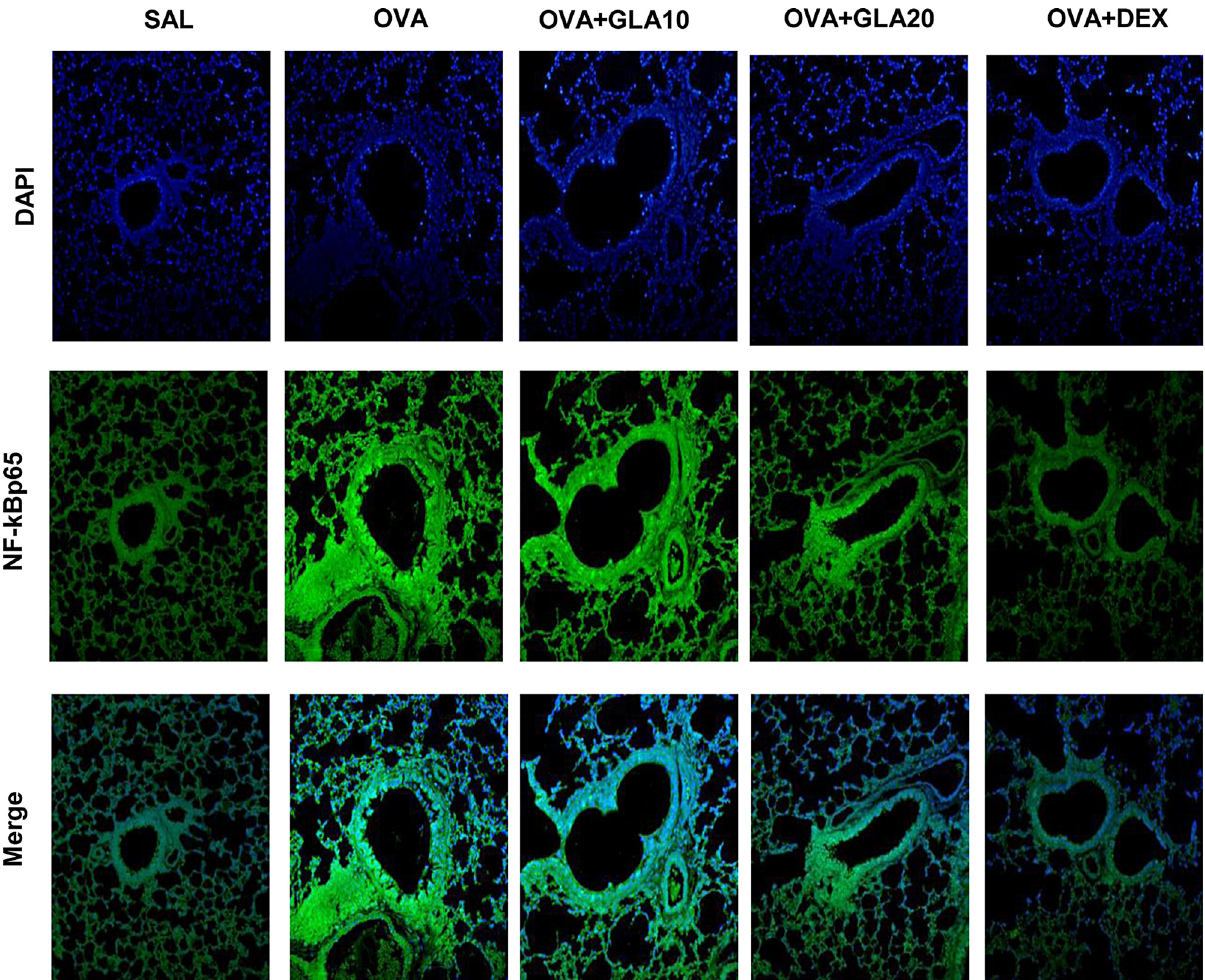
Figure 9: E ff ects of GLA on nuclear transcription of NF - κ Bp65 in lung tissue. The nuclear transcription of NF - κ Bp65 in lung tissue in the SAL, OVA - sensitized, Dex ( 1 mg/kg ) , and 10 and 20 mg/kg GLA groups was detected with immuno fl uorescence ( 200 ×) . The fl uorescent - speci fi c antibody ( green ) stained NF - κ